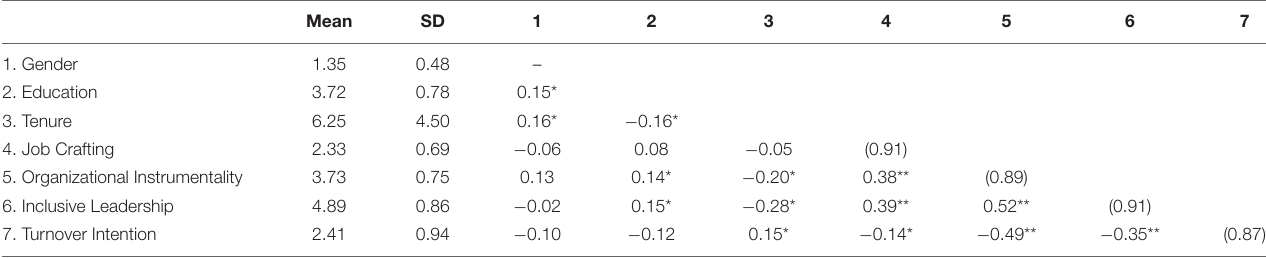
TABLE 1 | Descriptive statistics, reliability coefficients, and intercorrelations among